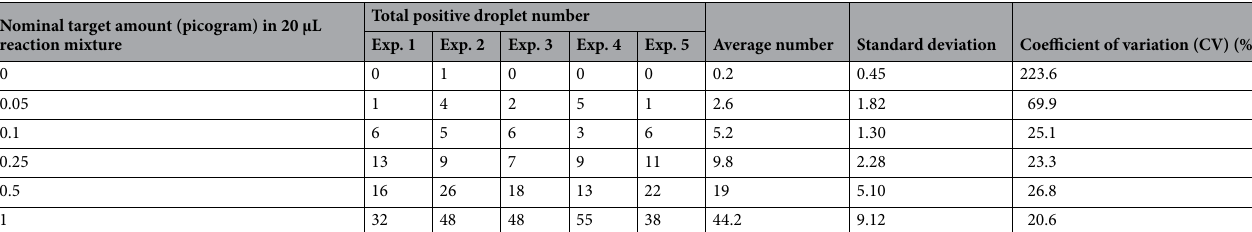
Table 1. Repeated droplet digital PCR experiments with low target concentration samples.